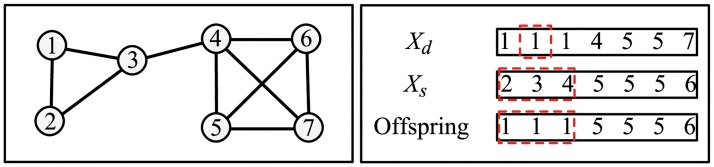
Illustration of one-way crossover procedure.Left, a toy network with 7 nodes; Right, node 2 is randomly chosen and the set of nodes with the same label as node 2 is {1,2,3} in X
s.